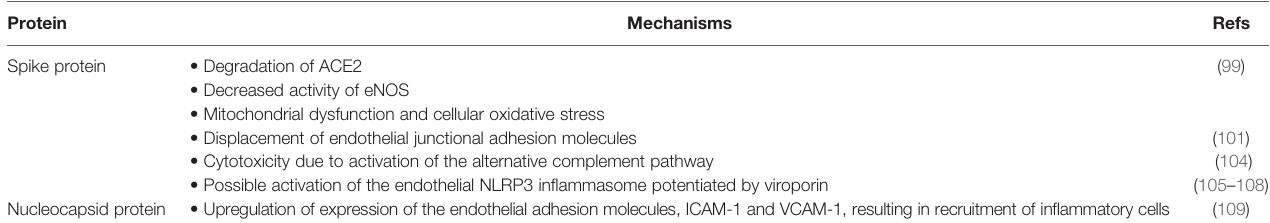
TABLE 4 | SARS-Cov-2 proteins that mediate endothelial cell dysfunction.